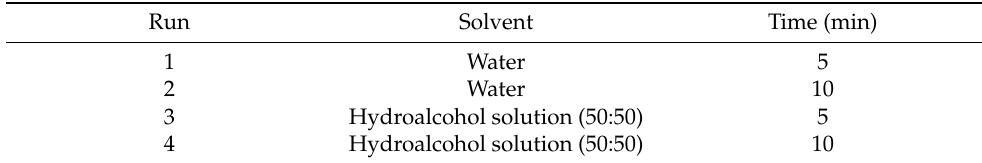
Table 8. Factorial design for ohmic heating (OH) extraction.